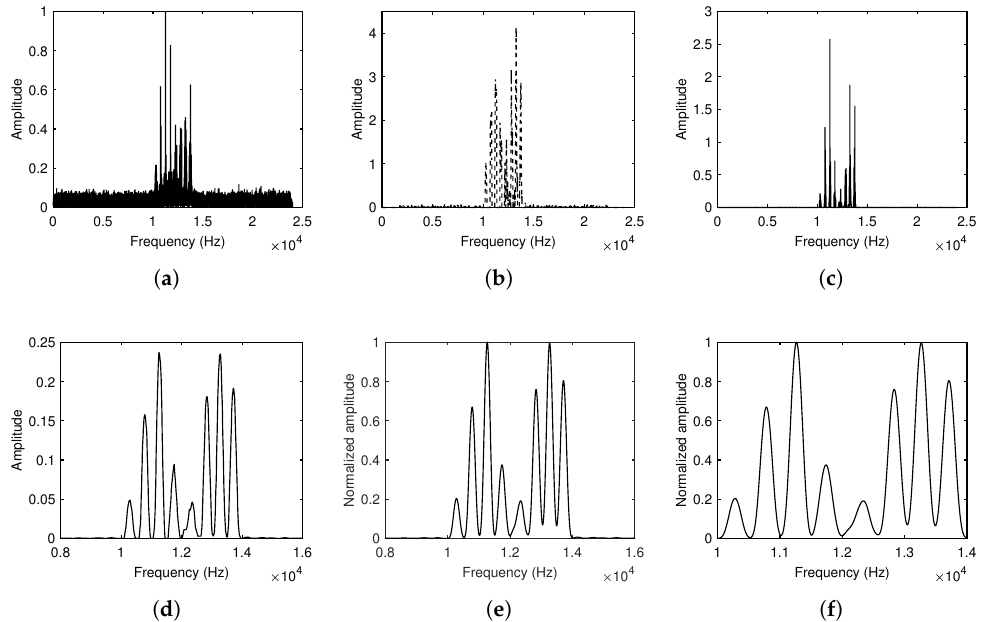
Figure 6. Waveform optimization of 8FSK. ( a ) Waveform after absolute value acquisition, ( b ) gain coefficient, ( c ) waveform after spectral peak enhancement, ( d ) partial enlargement of the waveform after moving average filtering, ( e ) partial enlargement of the waveform after Gaussian fitting, and ( f ) partial enlargement of ( e